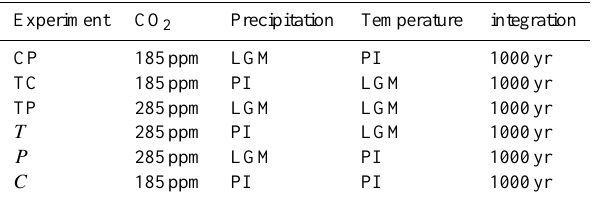
Table 2. Settings of the offline sensitivity experiments performed in this study. Precipitation and temperature are taken from the AOV(LGM) and the AOV(PI),